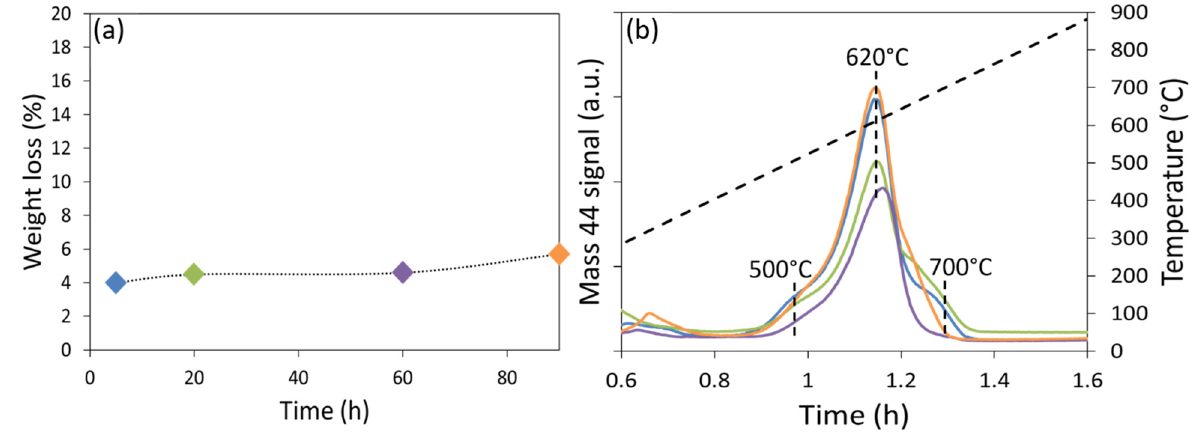
Figure 8. ( a ) Percentage weight loss during TGA and ( b ) MS signal for mass 44 of Ni/SBA-15 HT (N) after different stability time durations.